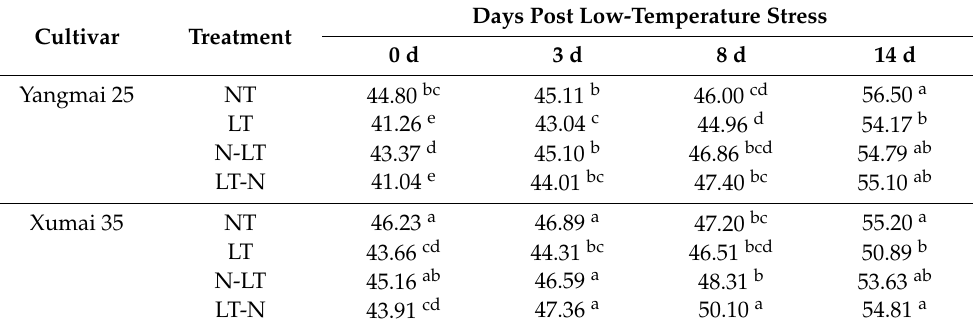
Table 1. Effects of remedial urea applied post or prior to low temperature on SPAD readings of wheat